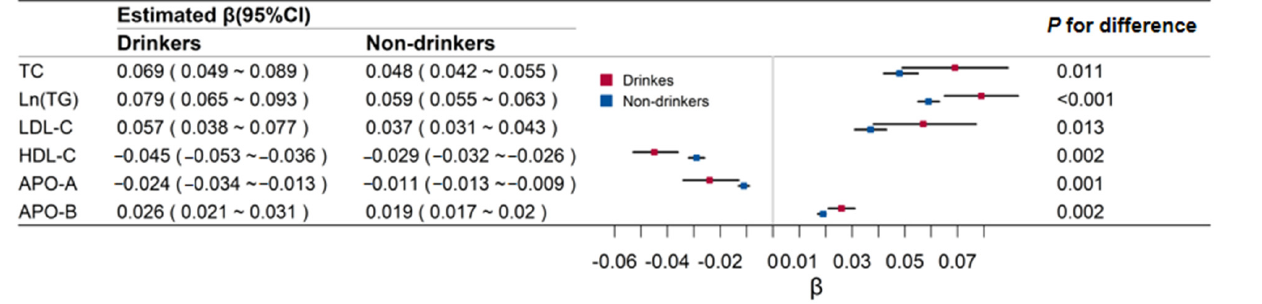
Figure 2. Regression coefficients and 95% confidence intervals (CI) of body mass index for lipids by alcohol drinking groups. TC means total cholesterol; Ln (TG) means Log transformed triglyceride; LDL-C means low-density lipoprotein cholesterol; HDL-C means high-density lipoprotein cholesterol; APO-A means apolipoprotein A; APO-B means apolipoprotein B.